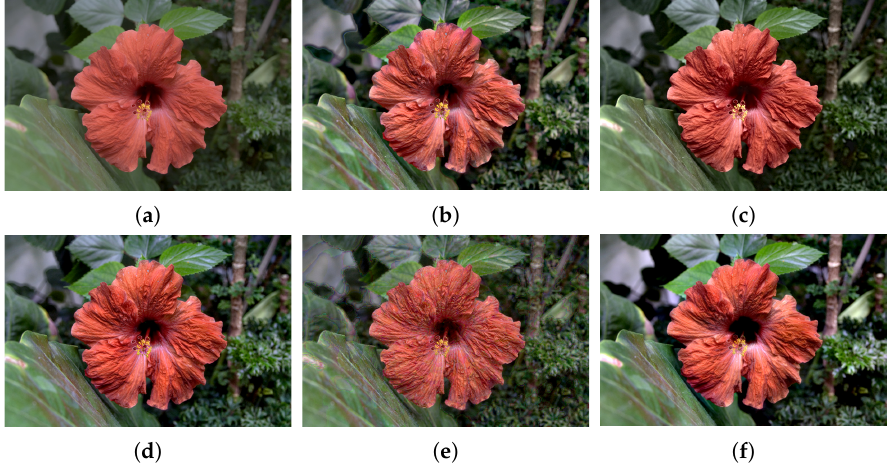
Figure 9. Comparison of our method with other methods in details exaggeration. ( a ) Input; ( b ) Bilateral [18] with σ s = 17, σ r = 20, s = 4; ( c ) WLS (http://www.cs.huji.ac.il/~danix/epd/ MSTM/flower/index.html) [21]; ( d ) l 0 -smoothing (http://www.cse.cuhk.edu.hk/leojia/projects/ L0smoothing/ToneMapping.htm) [24]; ( e ) l 0 -projection [29] with α = 127,920, s = 2; ( f ) ours with λ = 13, σ = 0.7, s =